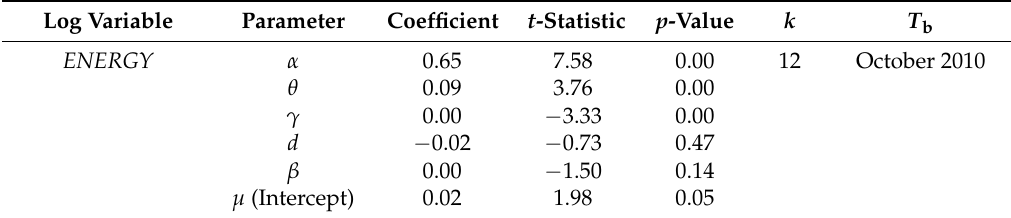
Table 3. The Perron break-date tests (Model